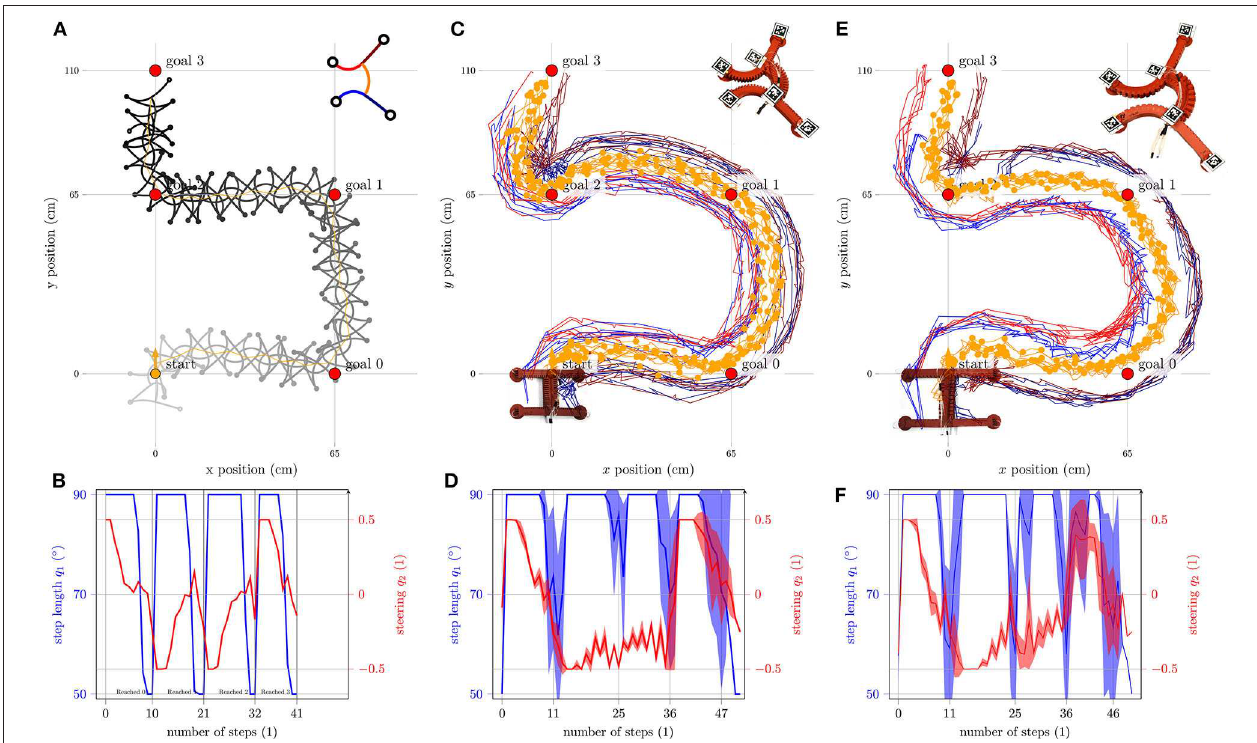
FIGURE 12 | Simulation and experiment with the Gait Pattern Generator in action. In (A) , the simulation of gait for a list of four target positions is shown. In (B) , the course of q 1 and q 2 is plotted over the number of steps. In (C,D) , the corresponding plots are shown for the experiment with the small prototype. (E,F) Show the experiment with the large prototype. For the experiments, the color code is as follows: front left foot (red), front right foot (dark red), tip of the torso (orange), torso’s end (dark orange), rear left foot (blue), and rear right foot (dark